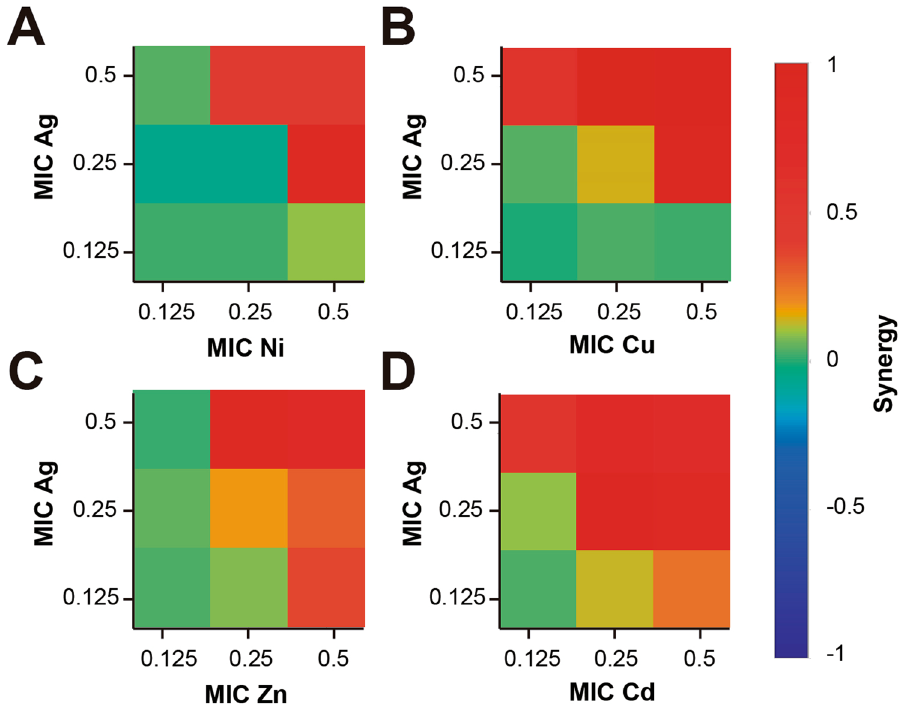
Figure 3. Analysis of Ag-Transition Metal Interactions. Classification of the different interactions between Ag-transition metal in Escherichia coli ATCC 11229. The interactions of Ag with ( A ) Ni, ( B ) Cu, ( C ) Zn and ( D ) Cd, are classified as synergistic, additive or antagonistic, value > 0, = 0 and < 0, respectively. Each checkerboard treatment was done in triplicates.